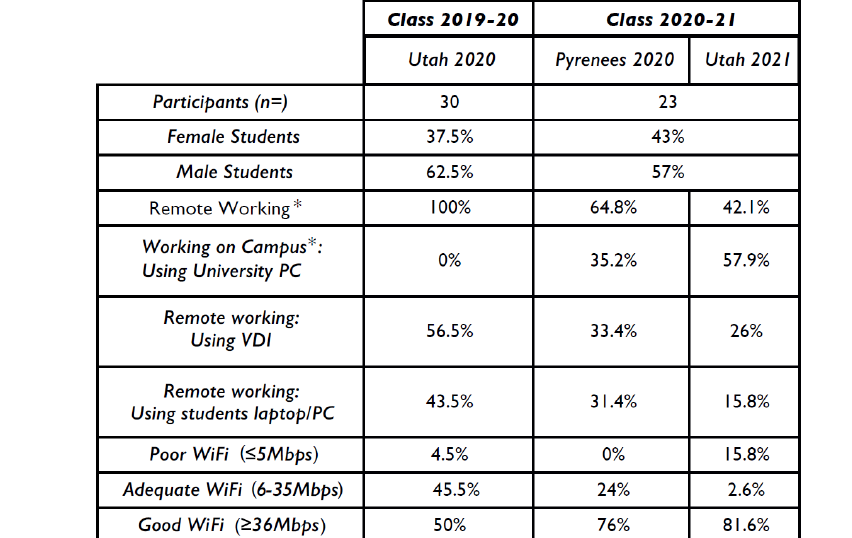
Table 1. Demographic and setting information for the